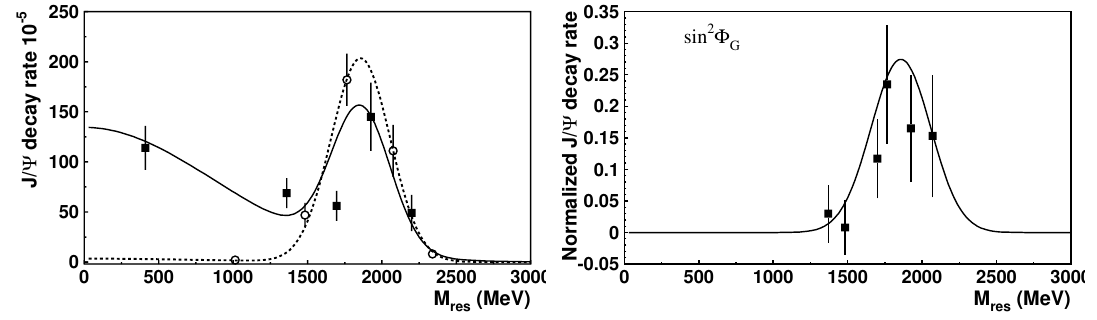
Figure 3: Left: Yield of radiatively produced scalar isoscalar “octet" mesons (open circles) and “singlet" (full squares) mesons. Right: Glueball component in the wave function.